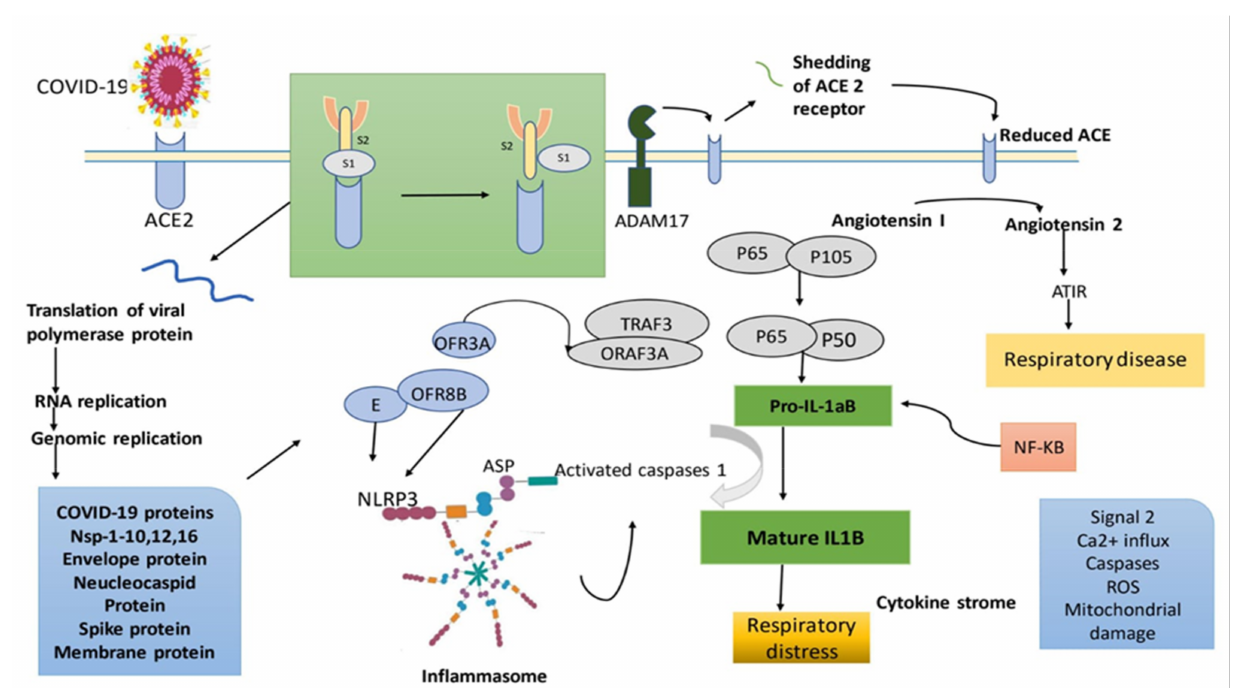
Figure 4. Potential mode of action of SARS- CoV-2, illustrated as SARS-CoV-2 attached to its target ACE-2. After that, the S1 and S2 molecules are cleaved, and ADAM 17 sheds ACE-2. As a consequence, the body’s level of Angiotensin II rises, resulting in respiratory discomfort. During contact, the virus fuses with the membrane and penetrates the cell, where protein synthesis and replication occur. ORF8b, ORF3a, and E proteins, and also the pathway of NF- κ B, all stimulate the inflammasome path, resulting in cytokine stimulation in different ways. A cytokine storm ensues, leading in respiratory discomfort. Here, ACE2, angiotensin converting enzyme 2; NF- κ B, nuclear factor- kappa B; ROS, reactive oxygen species; P65, P105, and P50 are the subunit of NF- κ B transcription complex; TRAF3, TNF receptor associated factor 3; ATR maintain to genome integrity by stabilizing replication forks and by regulating cell cycle progression and DNA [75]. Adapted with permission from ref. [75]. Copyright 2020 Elsevier